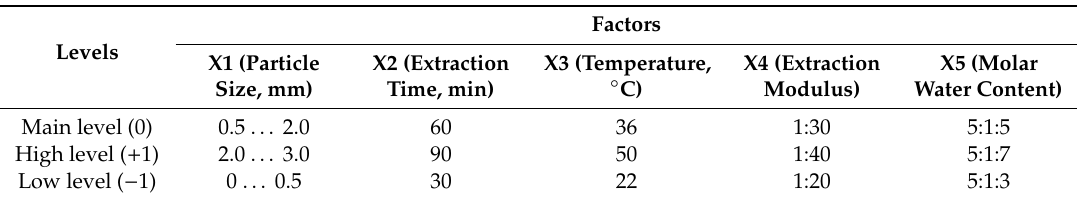
Table 2. The main factors and their variation levels for extracting phenyletanes and phenylpropanoids from R. rosea by NADES-UAE.